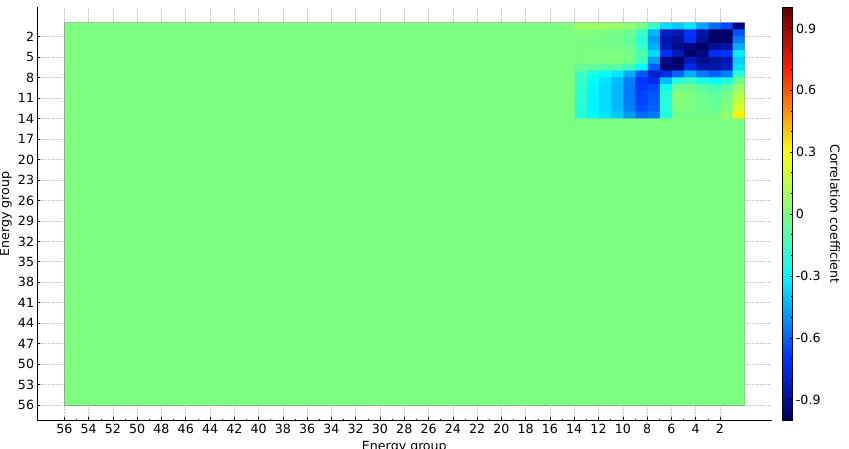
Figure 16. SCALE 56-group correlation matrix between 238 U elastic (MT = 2) and inelastic (MT = 4)